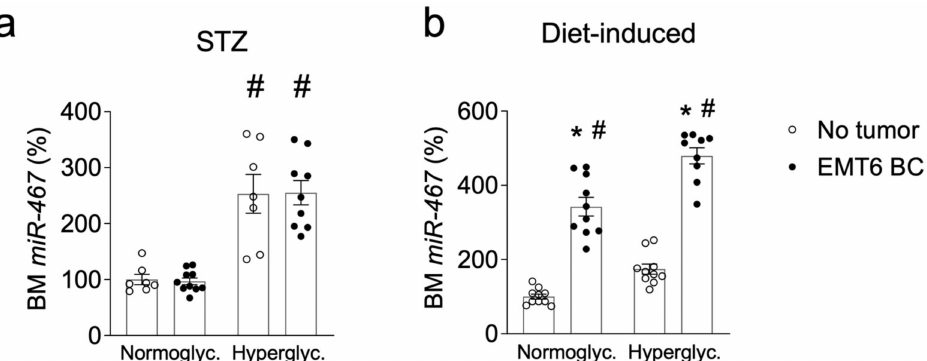
Figure 7. miR-467 expression is increased in bone marrow (BM) in hyperglycemic mice and in C57BL/6 mice with tumors. ( a ). BM was collected from normoglycemic and hyperglycemic (STZ-treated) WT BALBc mice and ( b ). WT mice C57BL/6 mice on Western diet. Bars represent the mean ± SEM. * p < 0.05 comparing to the average levels in the control group without tumors. # p < 0.05 comparing normoglycemic controls. Control mice without tumors = open circles; mice with tumors = closed